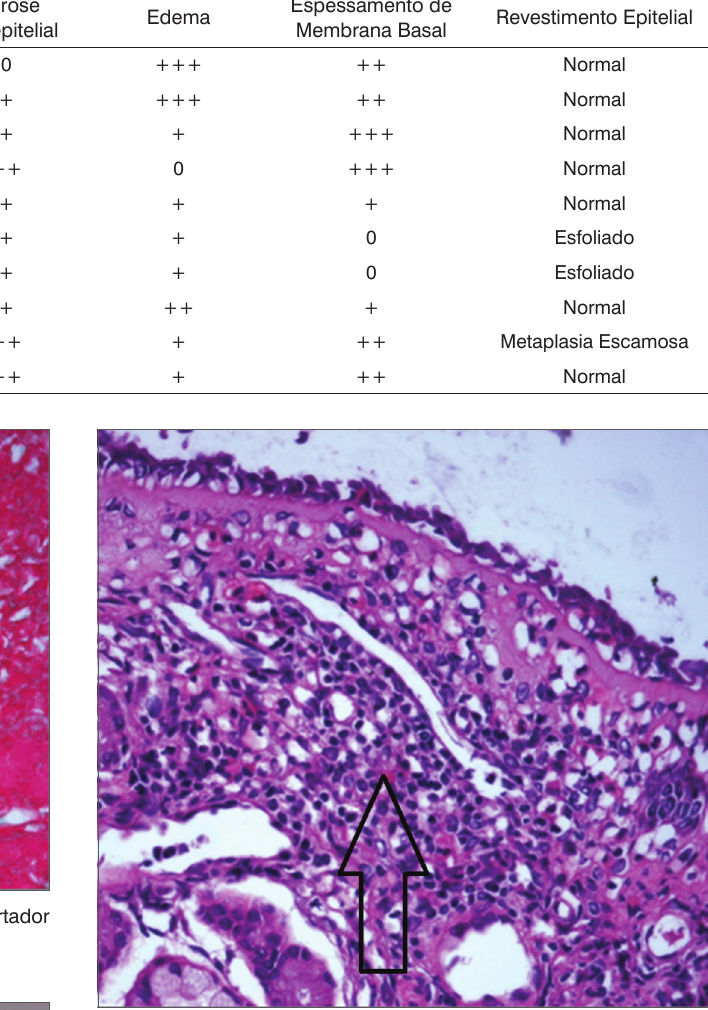
Figura 3. Infiltrado mononuclear na mucosa nasal de portador do HTLV-1 com rinite não alérgica. HE, 400X.